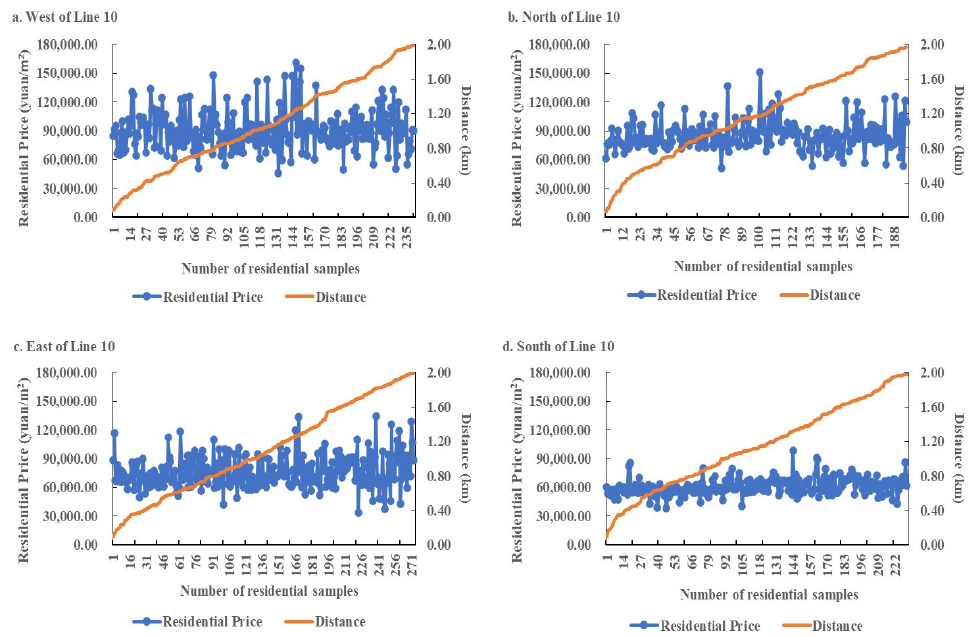
Figure 2. Relationship between residential price and the distance to the nearest subway station in each area along Metro Line 10.